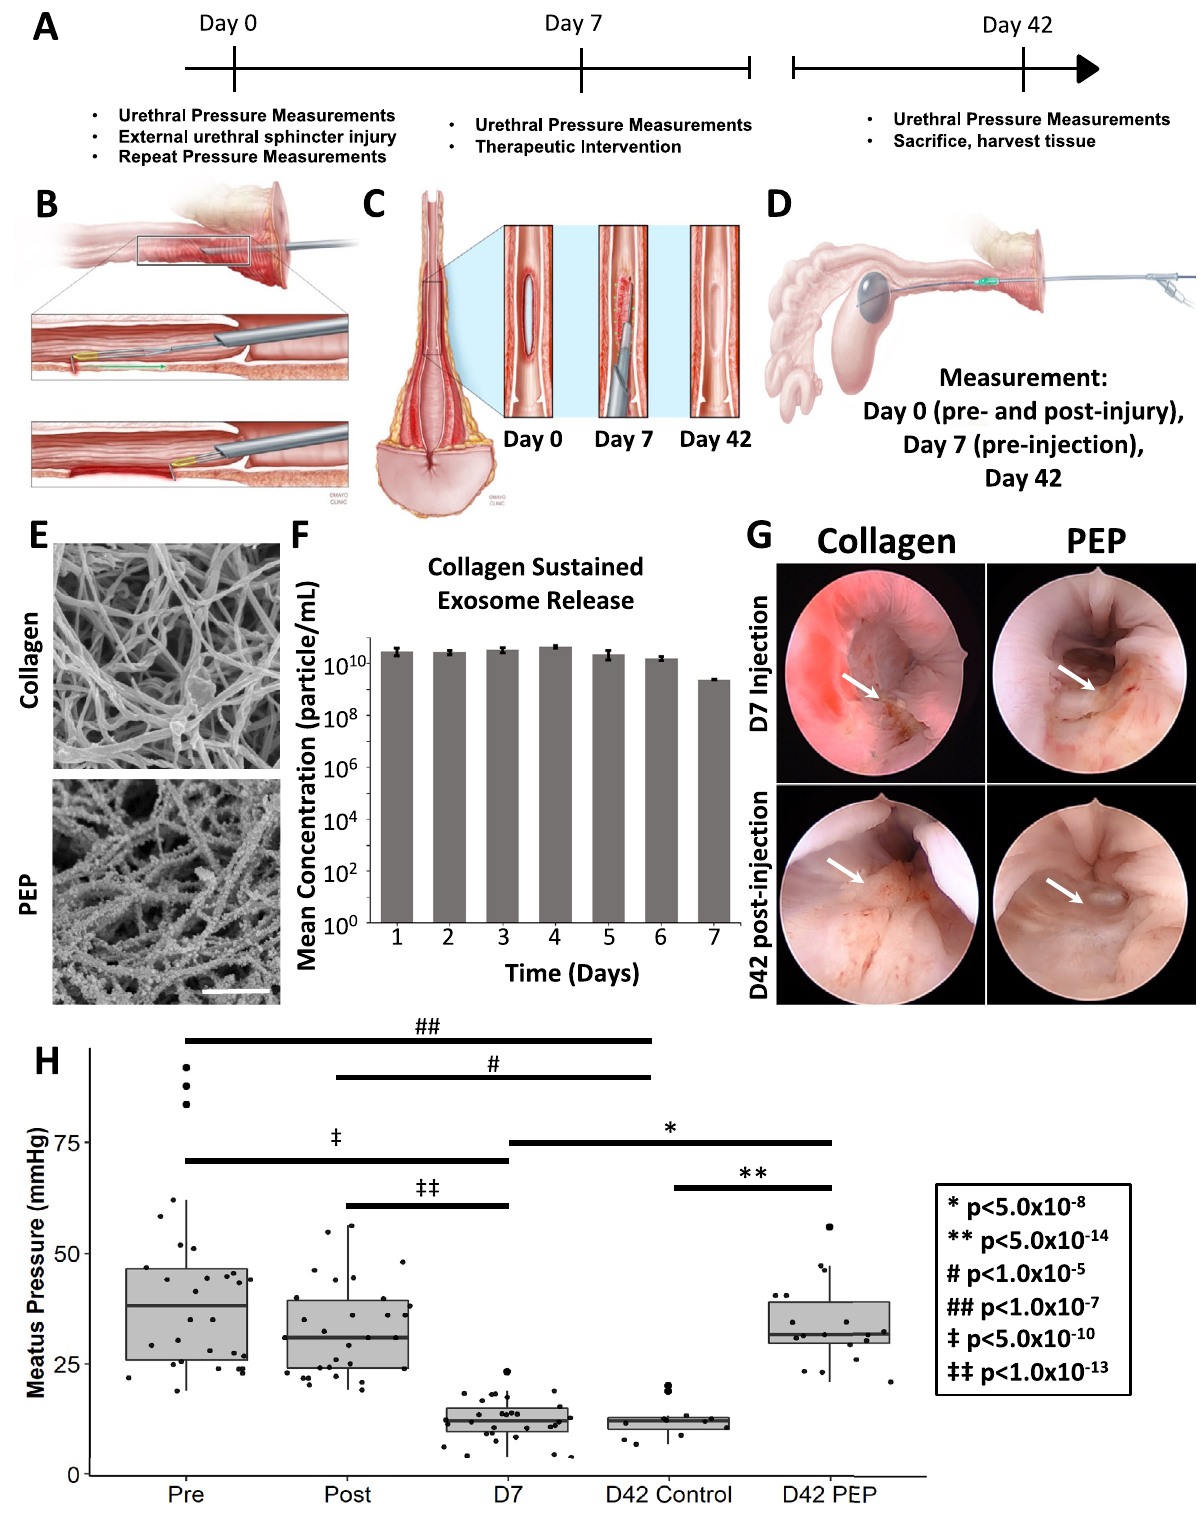
column fi lter (Sigma) at 4000 × g for 15 min. Three mice were injected intramuscularly into the right quadriceps with 100 µL of DiR labeled PEP (5 × 10 12 exosomes/mL). Sequential assessment of PEP biodistribution was assessed by the Xenogen IVIS Spectrum (PerkinElmer). In vivo